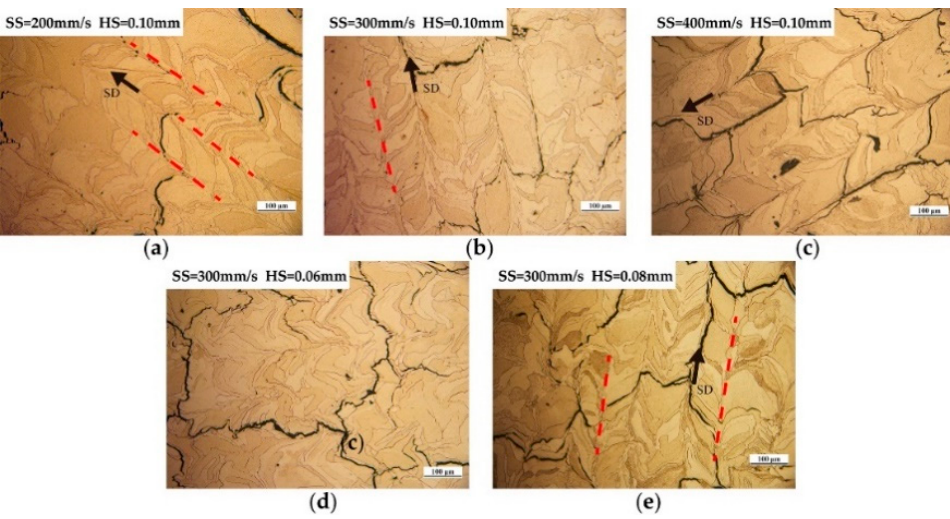
Figure 9. Microstructure of tungsten samples at different process parameters. ( a ) T21, ( b ) T24, ( c ) T27, ( d ) T22, ( e ) T23.